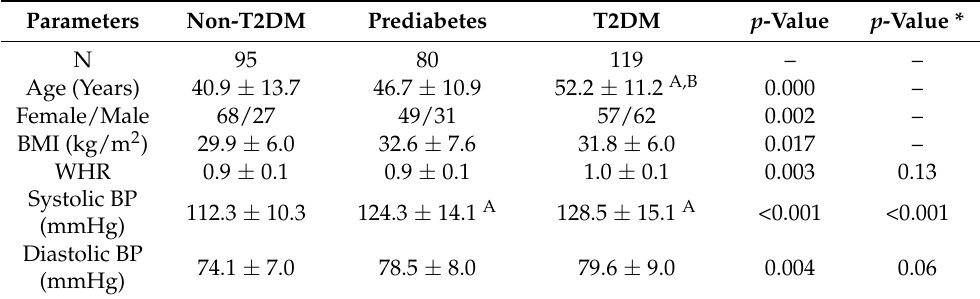
Table 1. Demographic and clinical characteristics of subjects according to T2DM